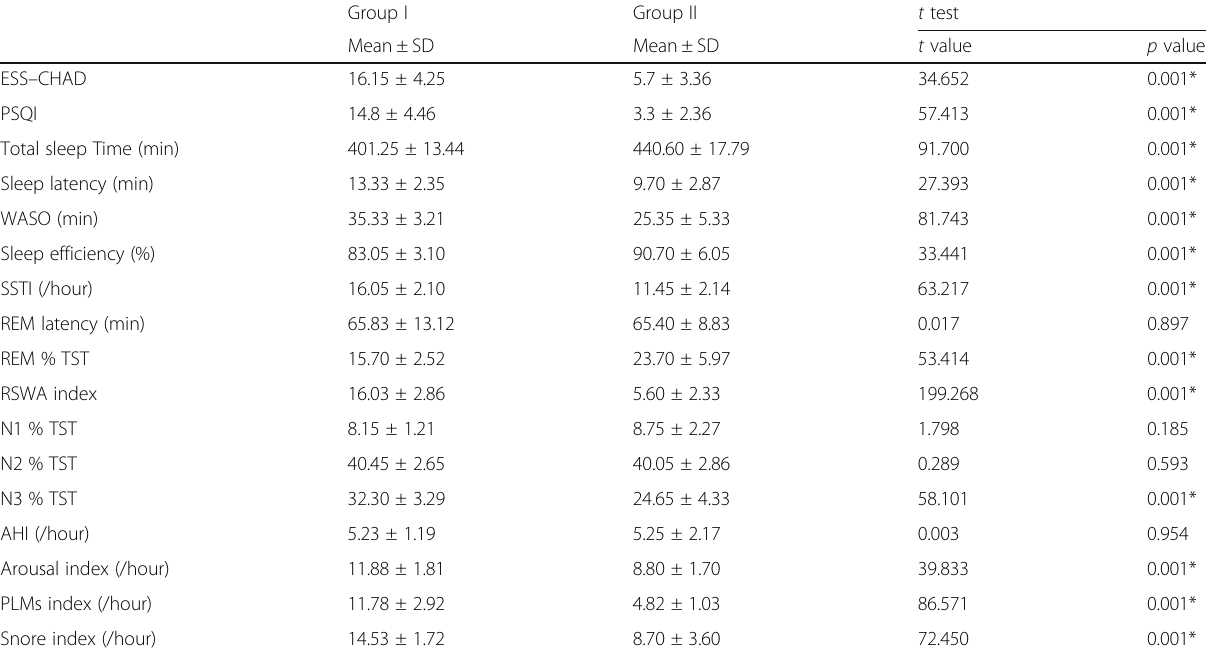
Table 2 Statistical analysis of the studied sleep scales and polysomnographic results among school children with migraine (group I) and healthy control subjects (group II) Group I Group